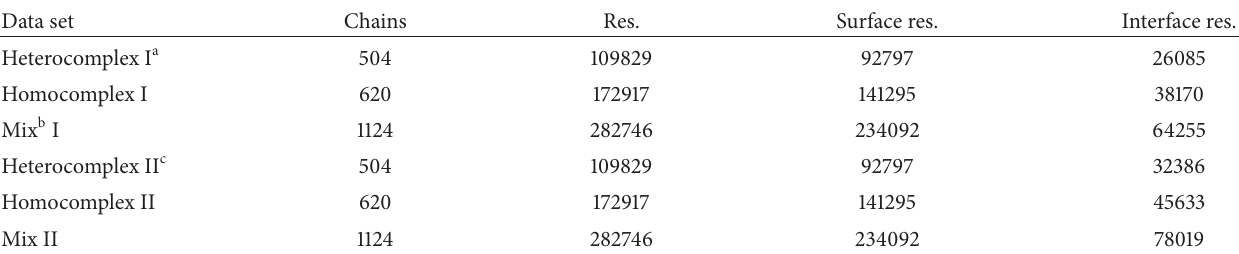
Table 1: Summary of six data